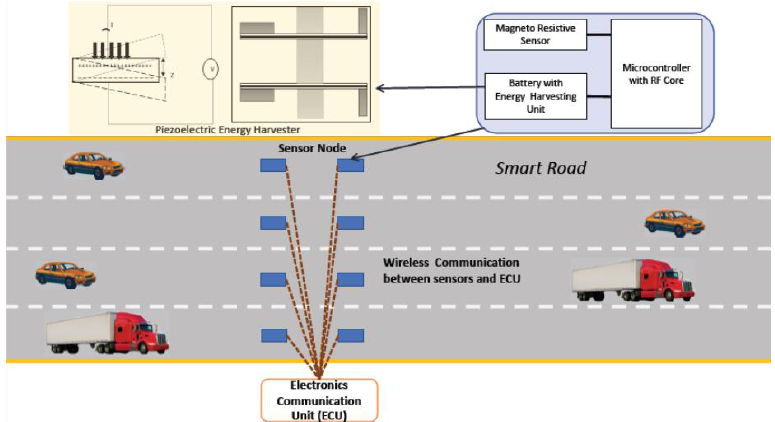
Figure 3. Application of the harvester system [10]. Infrastructures 2020 , 5 , x FOR PEER REVIEW